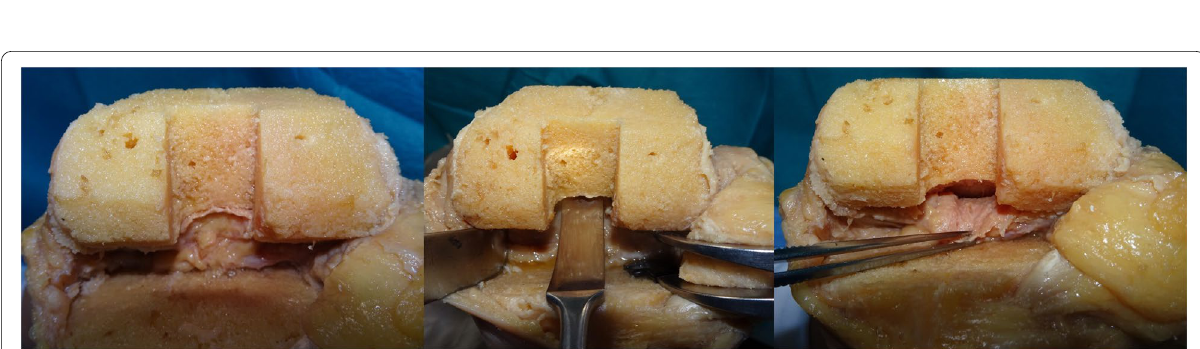
Fig. 5 Posterior capsular release using a curved osteotome. The left figure shows the attachment site of the posterior capsule at the intercondylar fossa of a femur. The middle figure shows posterior capsular release at the intercondylar fossa. The posterior capsule was completely detached from the posterior femoral cortex. A spreader was used to create adequate space to perform posterior capsular release. The right figure shows the attachment site of the posterior capsule at the intercondylar fossa after capsular release